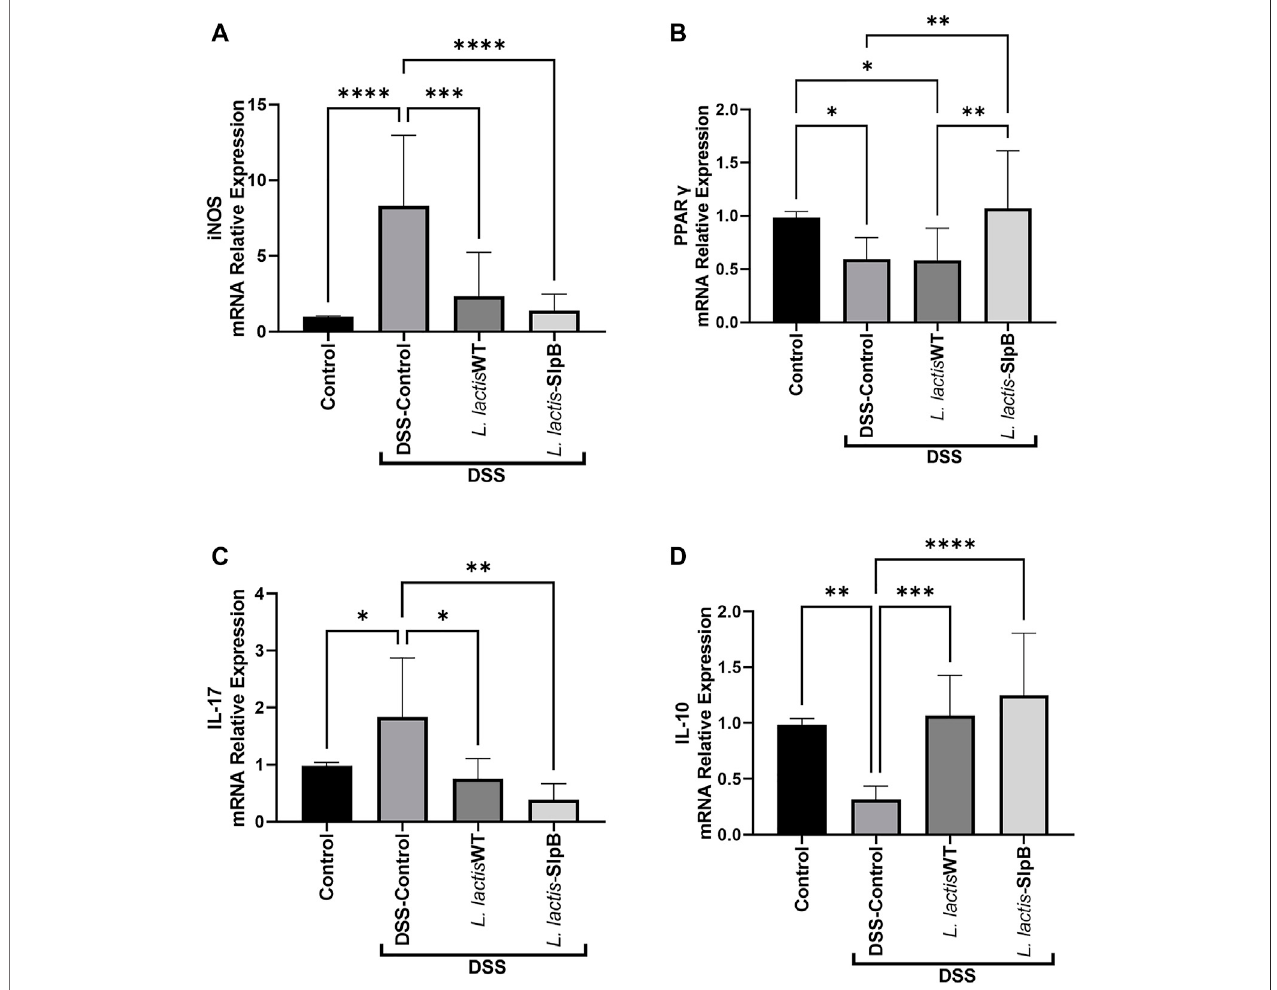
FIGURE 6 | L. lactis -SlpB strain modulates expression of pro and anti-in fl ammatory genes implicated in ulcerative colitis. Quanti fi cation of the expression of the genes inducible nitric oxide synthase ( inos ) (A) , peroxisome proliferator-activated receptor-gamma ( pparg ) (B) , as well as interleukin-17 ( il-17 ) (C) and interleukin-10 ( il- 10 ) (D) proandanti-in fl ammatorycytokines,isshown.Thedatarepresentthemean ± SDofsixmicepergroup.One-wayANOVAandTukey ’ s post - hoc testswereused for multiple comparisons ( n (cid:2) 6). Asterisks represent statistically signi fi cant differences as follows: p p < 0.05, pp p < 0.01, ppp p < 0.001, pppp p < 0.0001.